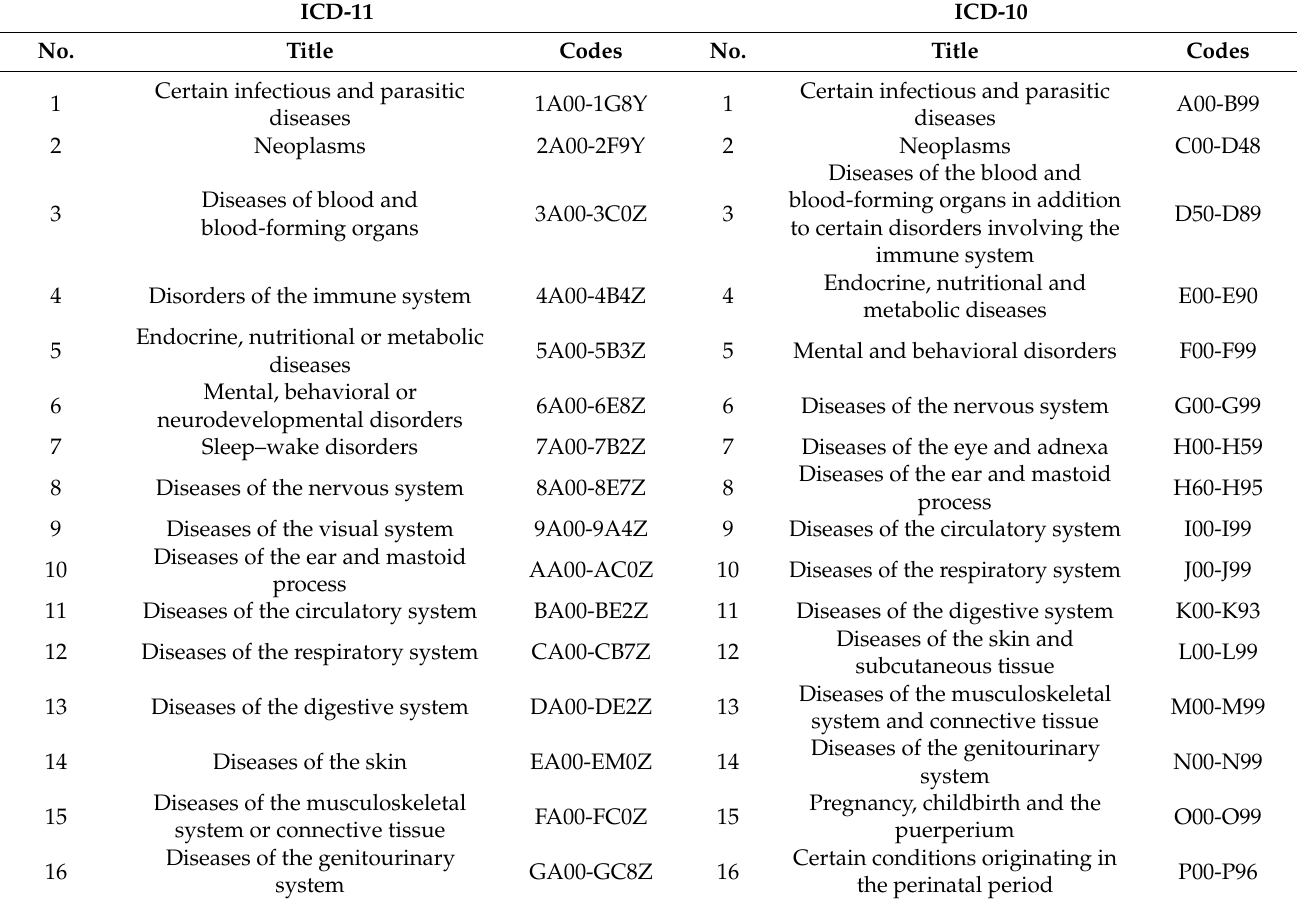
Table 1. Comparison of ICD-11 and ICD-10 chapters and codes. ICD-11